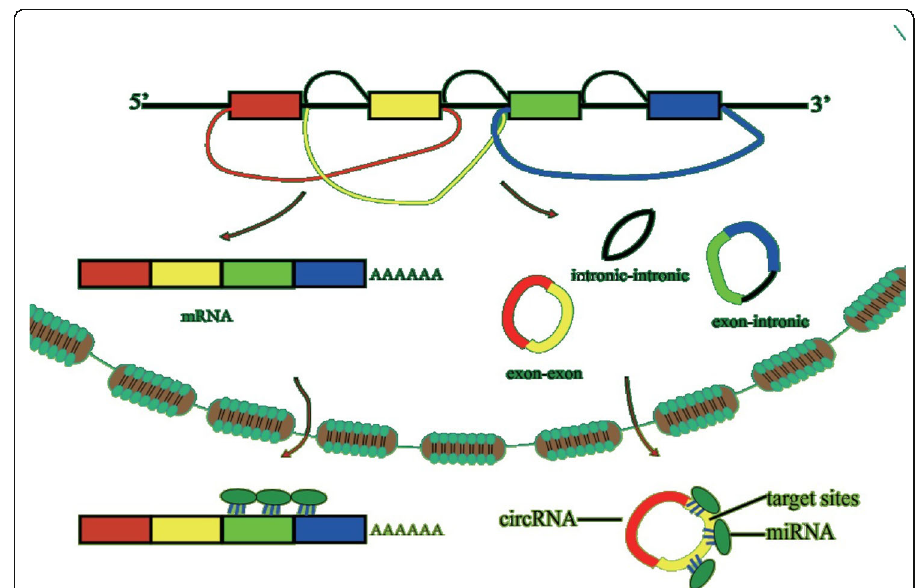
Fig. 4 The three forms of covalently joined circRNAs in cells: exon-exon, exon-intron (intronic), and intron- intron (intronic-intronic). circRNAs may serve as miRNA sponges to prevent binding to target